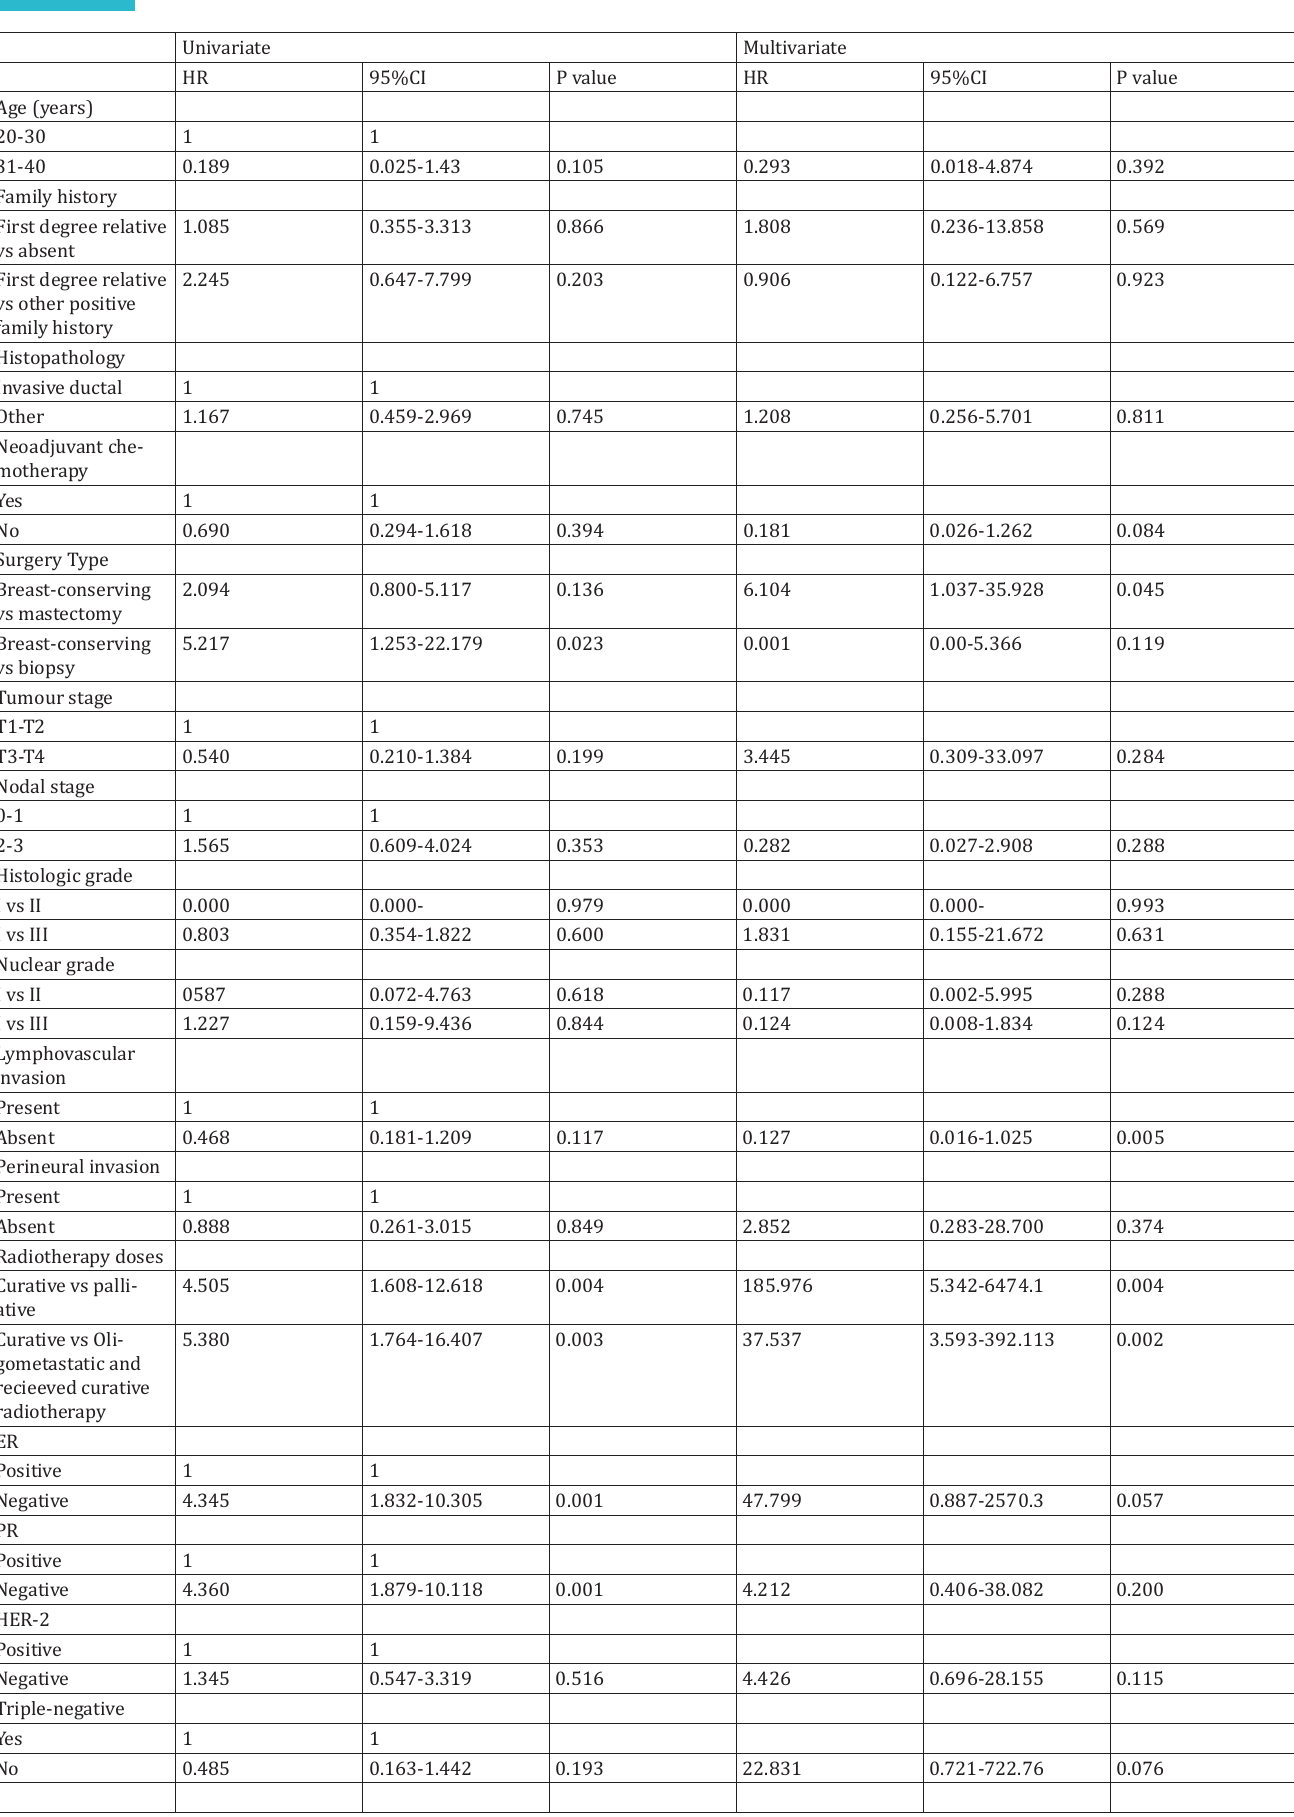
Univariate and multivariate for DFS